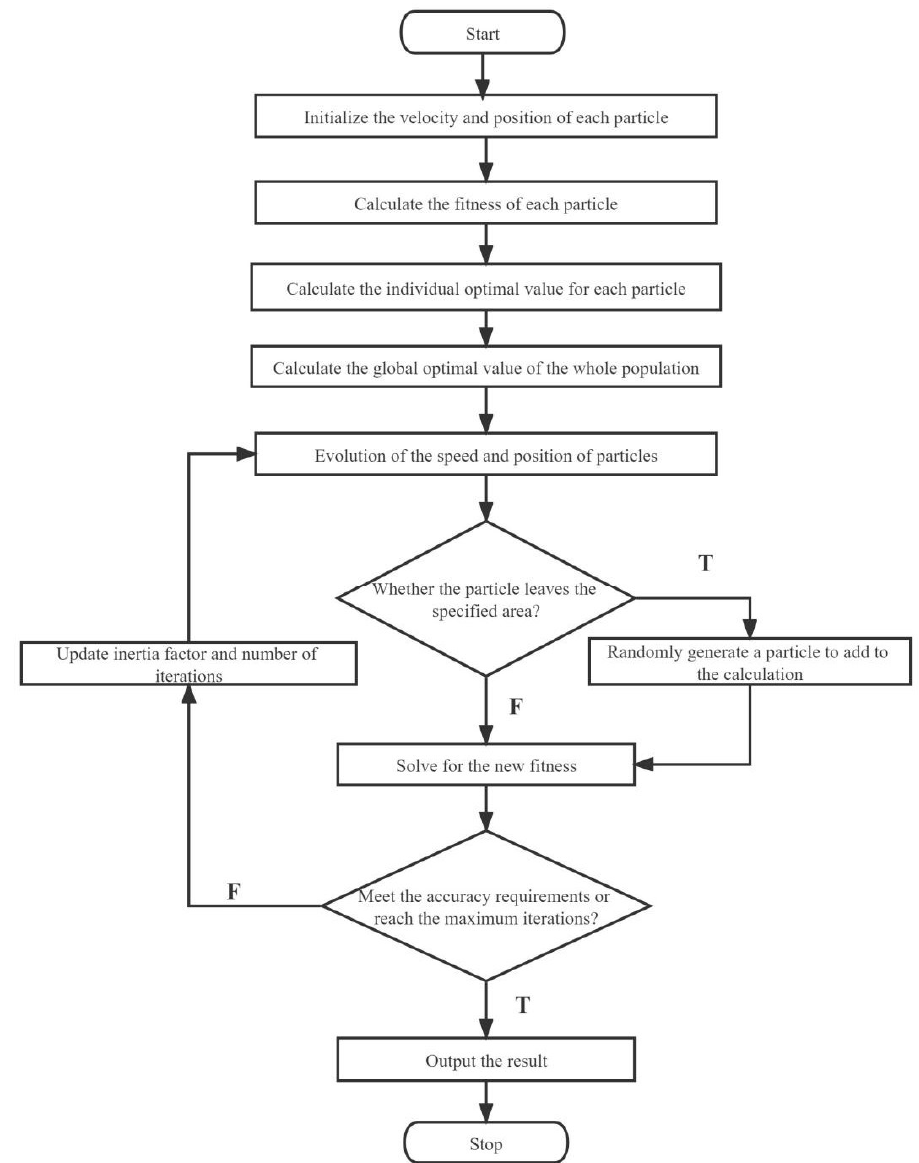
Figure 1. Flow chart of improved particle swarm optimization algorithm.